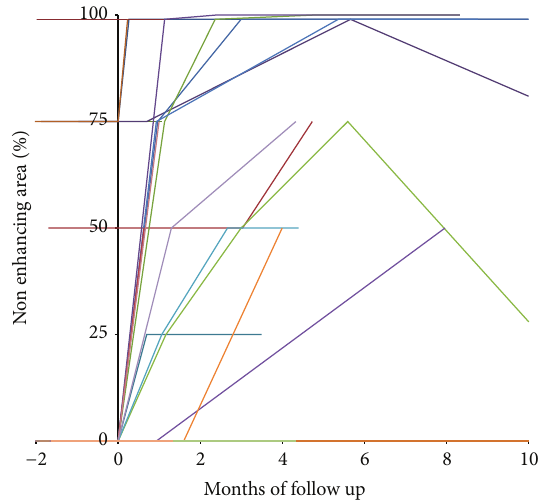
Figure 7: Nonenhancing area within the treated metastatic lesion over the follow-up period (each line represents an individual lesion).